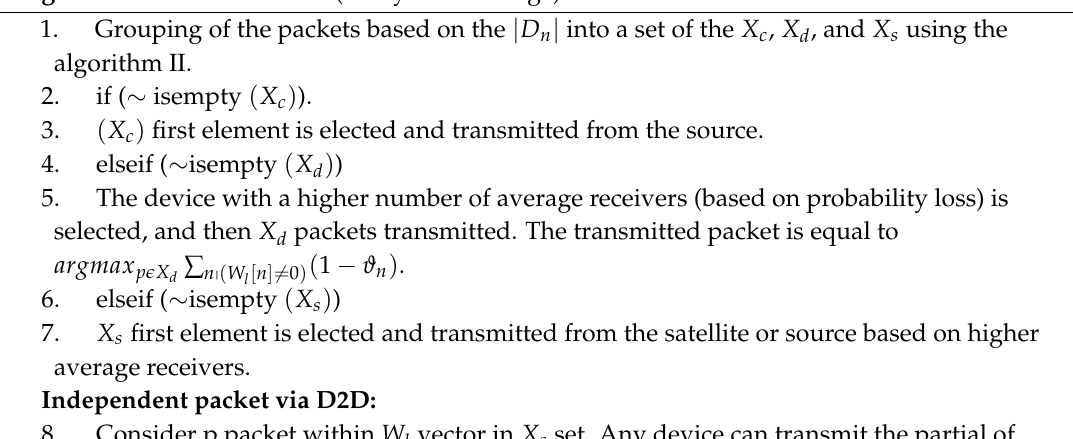
Algorithm 4: MANC Stream (Lossy second